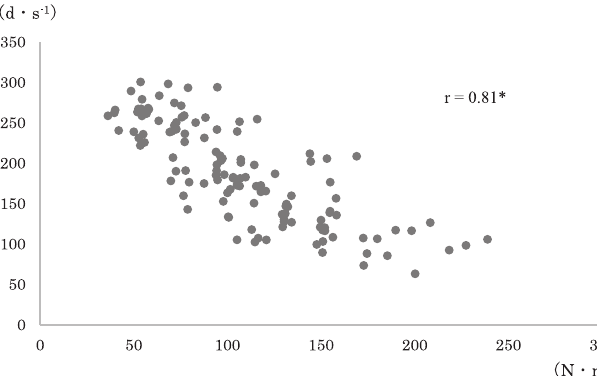
Figure 9 Correlation coefficient for average torque before and after modification of the leg extension